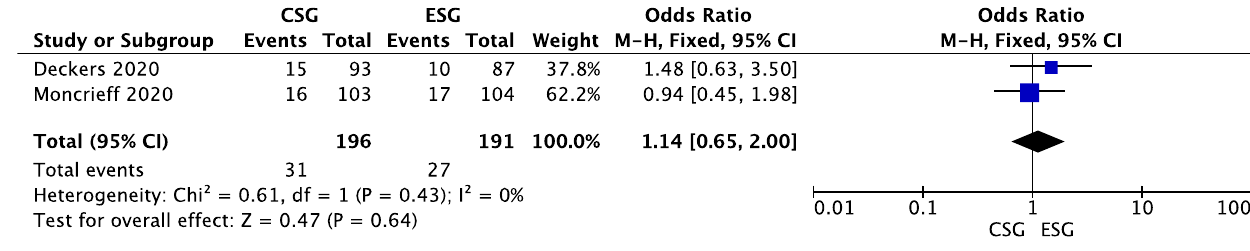
Figure 2. Melanoma recurrence—forest plot [13,14].